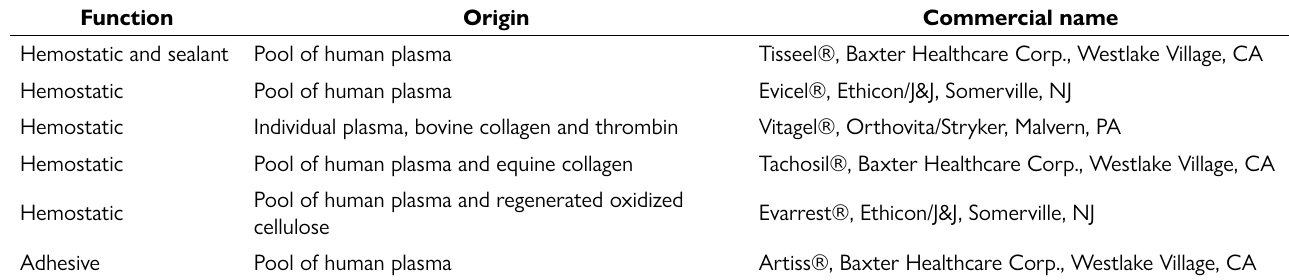
Table 1. Fibrin sealants available in the U.S. and approved by the FDA.